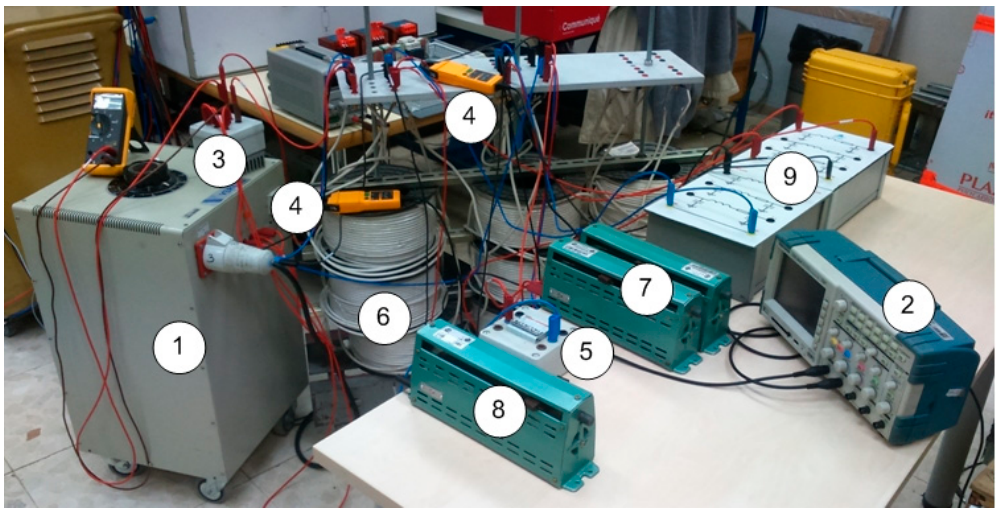
Figure 12. Experimental set-up. 1: AC power supply; 2: oscilloscope; 3: rectifying bridge; 4: current measurement units; 5: fault switch; 6: cable and shield modules; 7: load resistor; 8: fault resistance; 9: overhead line modules.